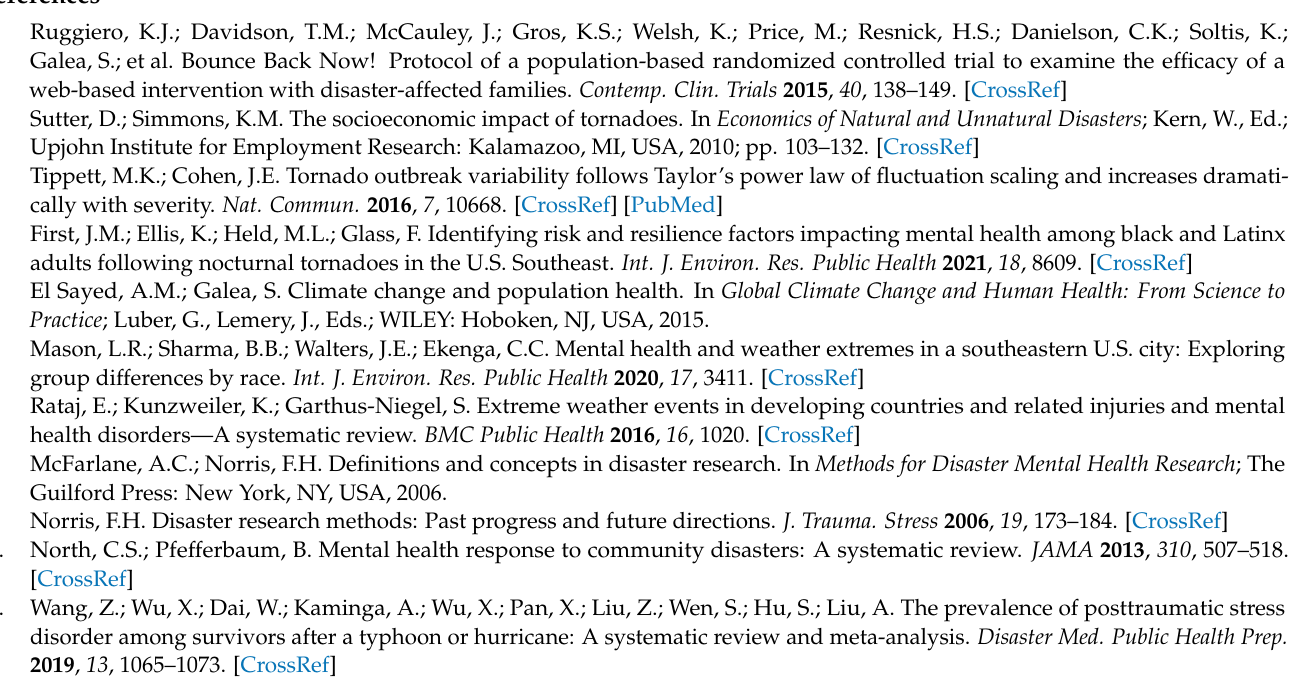
Table S2: Supporting Information: Study characteristics and